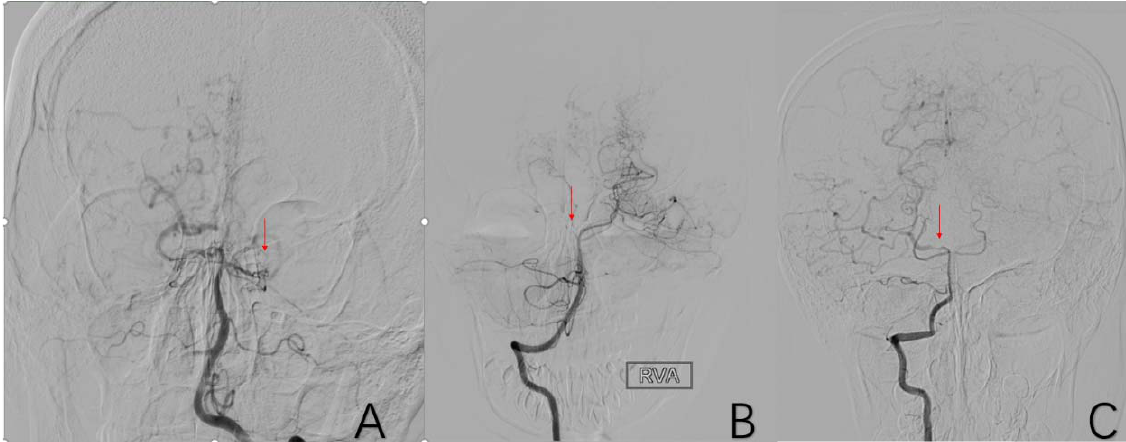
Figure 7. ( A ) is a 52-year-old female. Vascular occlusion of distal vessels from P1. ( B ) is a 6-year-old male with posterior cerebral artery initiation occlusion. ( C ) is an 8-year-old male who had localized stenosis in P1 with essentially normal distal vessel visualization. The red arrows in ( A – C ) are the tool of the PACS and show the location of PCA